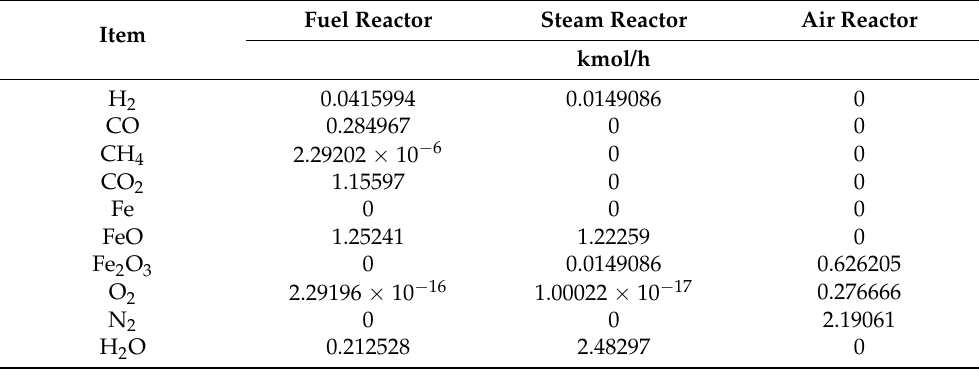
Table 4. Gas products and oxygen carrier results of the proposed process.